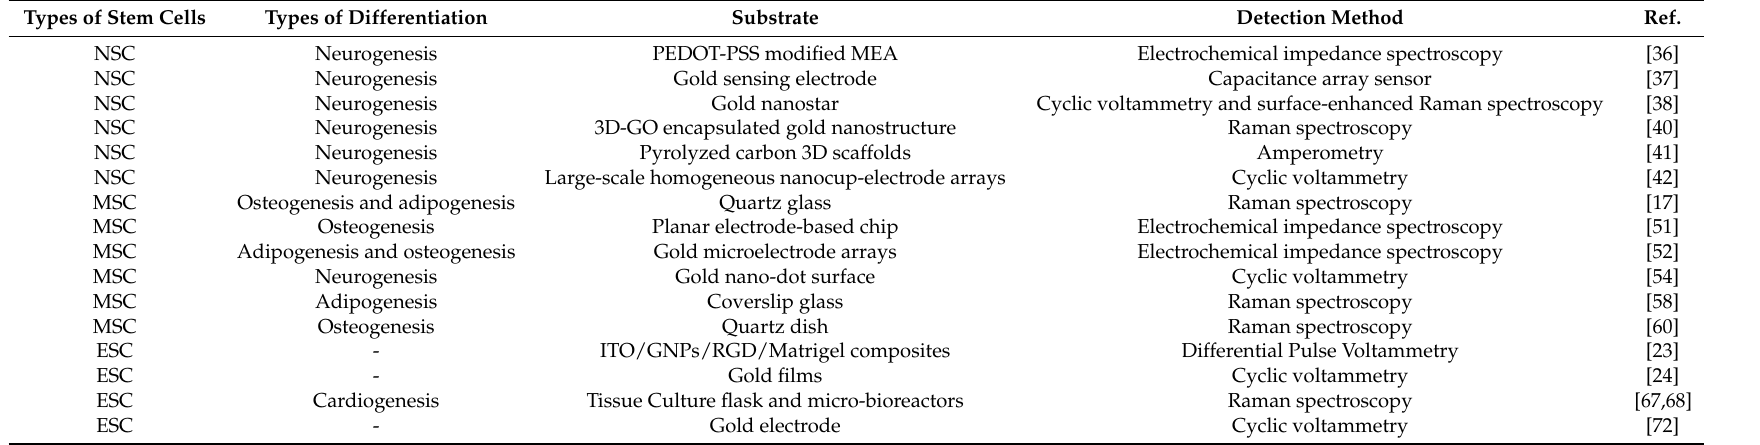
Table 1. Biosensing Platforms for Real-time and Non-invasive Monitoring of Stem Cell Pluripotency and Differentiation. Types of Stem